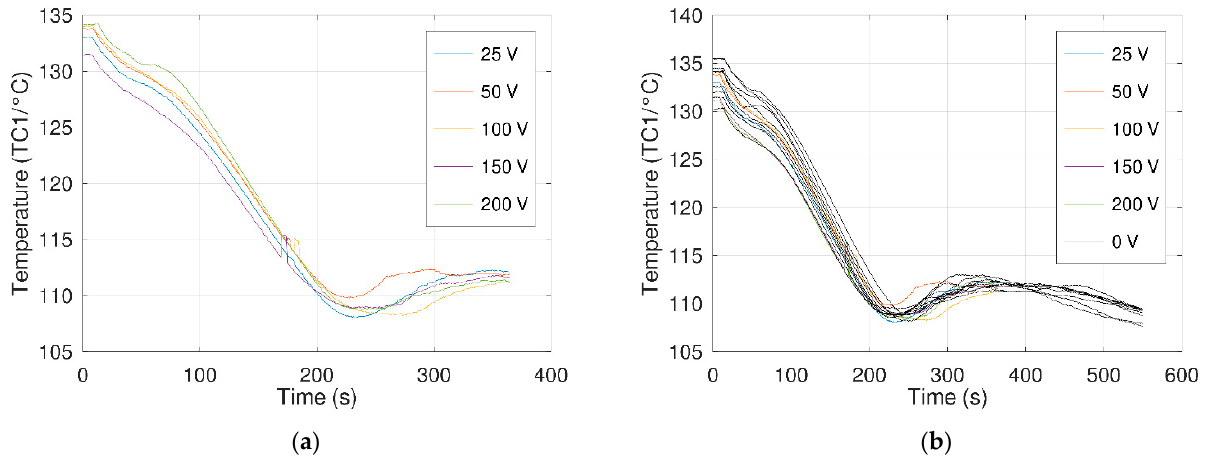
Figure 8. Thermograms obtained at the level of the electrode assembly (TC1) during the free cooling: ( a ) with electrical fields from 25 V to 200 V; ( b ) with electrical fields from 25 V to 200 V and superposition of the 9 thermograms obtained without an electric field (0 V). Table 6. Obtained results applying a current.